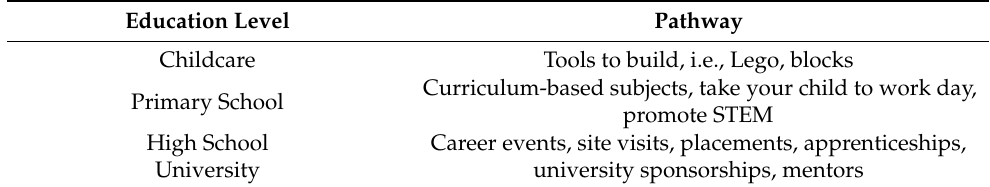
Table 2. Methods of involving women in construction through their education